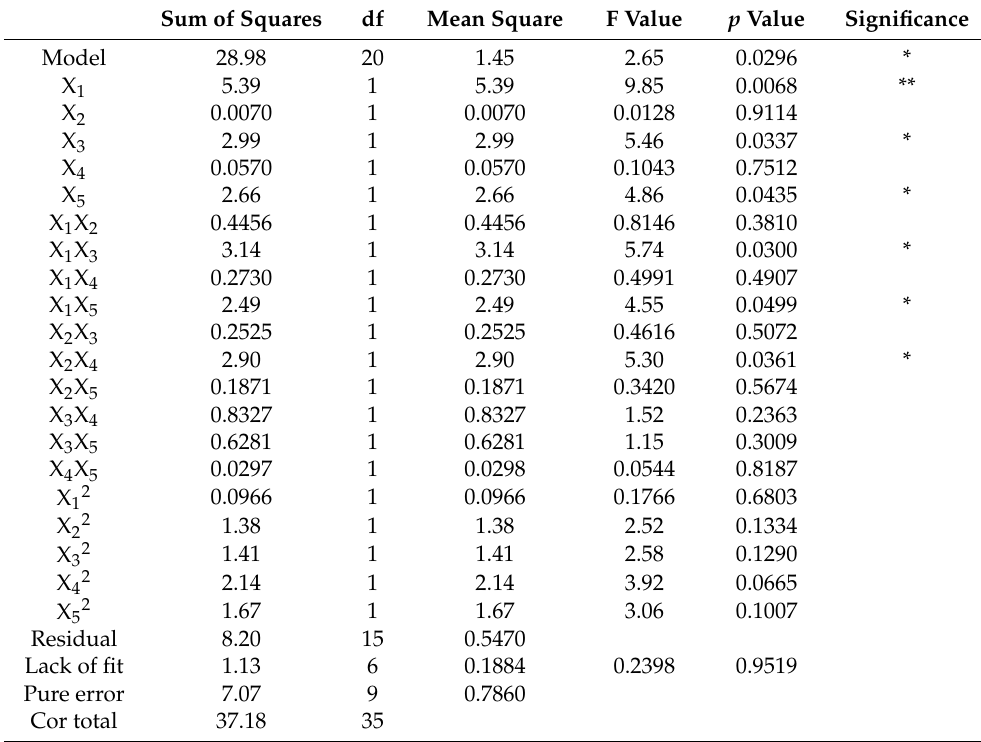
Table 2. Analysis of variance of regression equation for adhesion rate of L. fermentum DALI02. Sum of Squares df Mean Square F Value p Value Significance Model